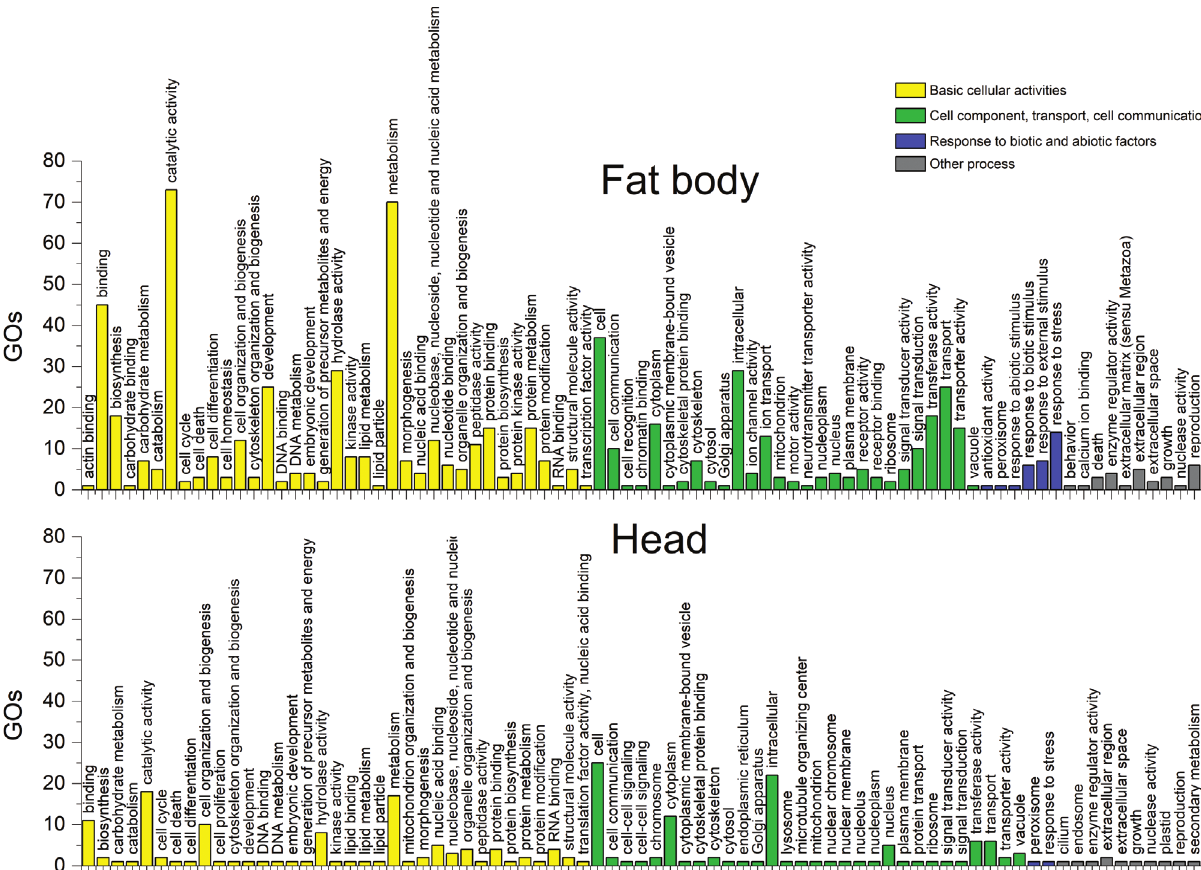
Figure 2 - GO slim terms distribution of upregulated genes in the fat body and head of N. cinerea